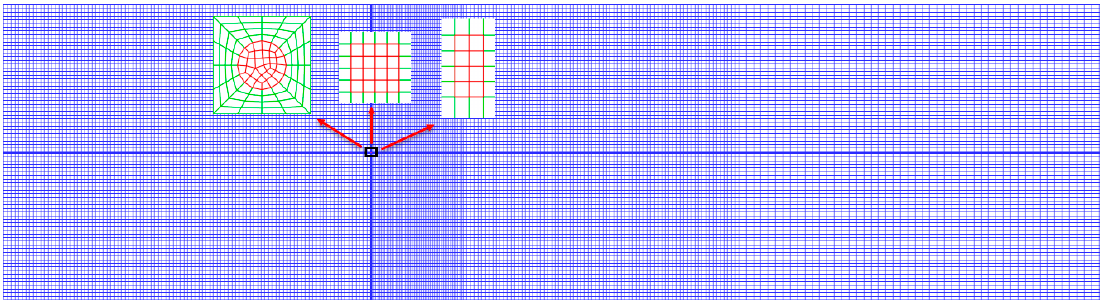
Figure 2. The grid of the numerical model.